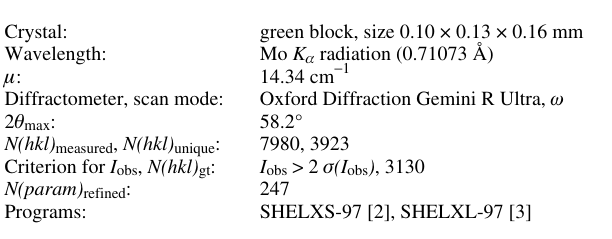
Table 1. Data collection and handling.